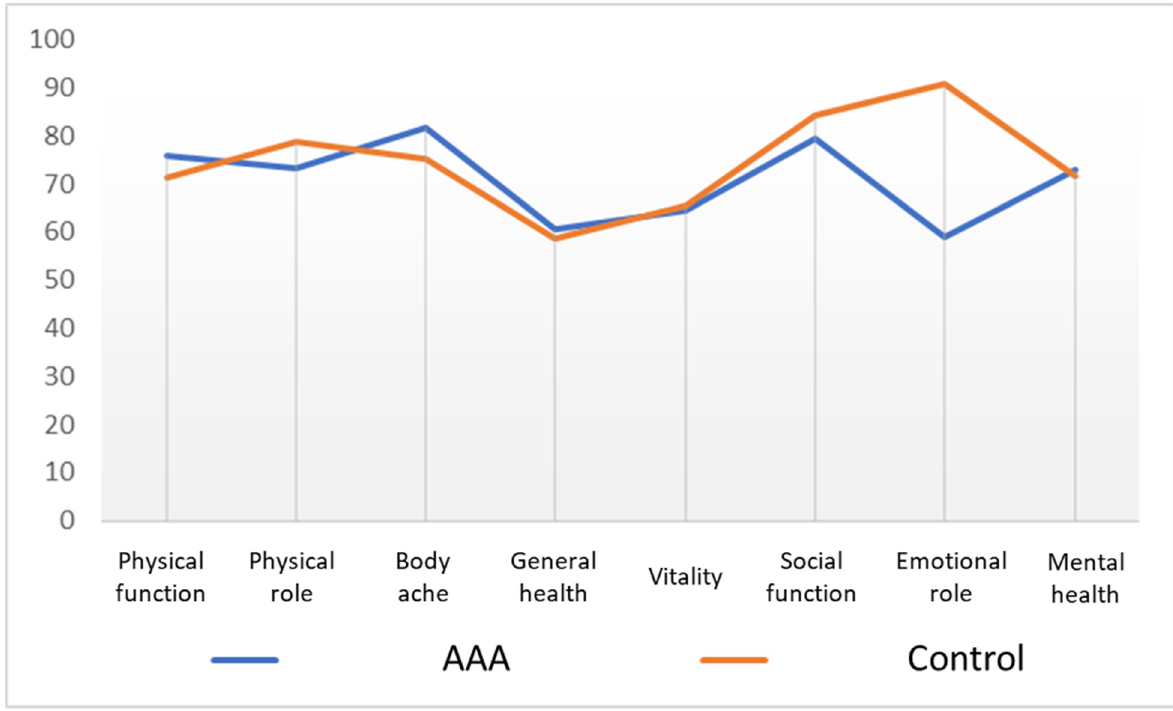
Figure 1. Mean scores in each of the dimensions of the SF-36 in patients operated on for abdominal aortic aneurysms (AAAs) and the general Spanish population (control).